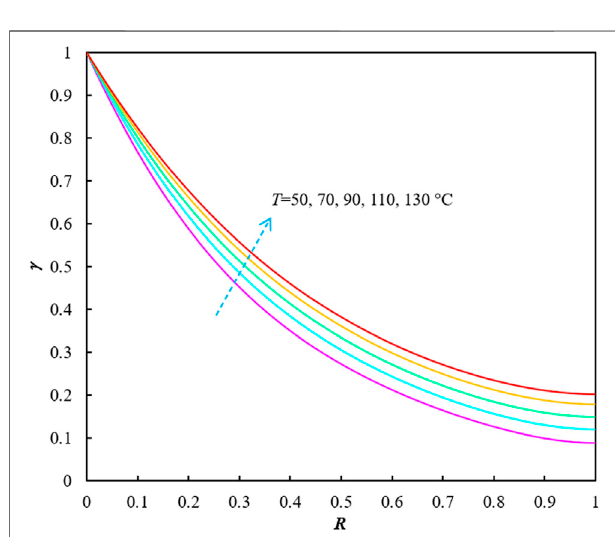
FIGURE 2 | The effects of reservoir temperature on c vs. R relationships ( p i (cid:1) 70 MPa and c g (cid:1) 0.6).